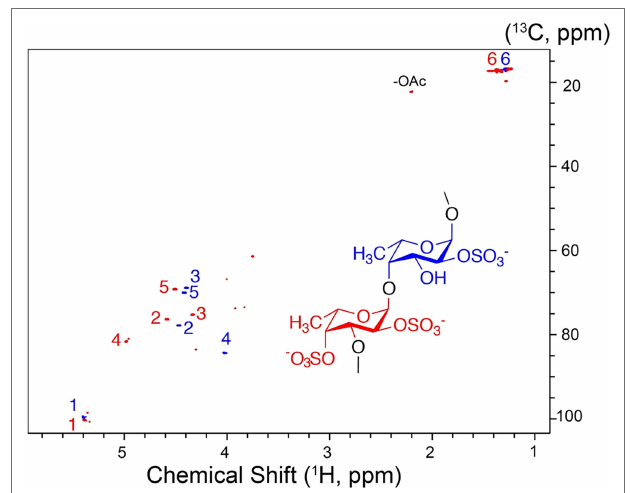
FIGURE 10 | 1 H- 13 C NMR spectrum and molecular structure of the high molecular weight product obtained upon F. evanescens fucoidan degradation with Fhf2 Δ 484.